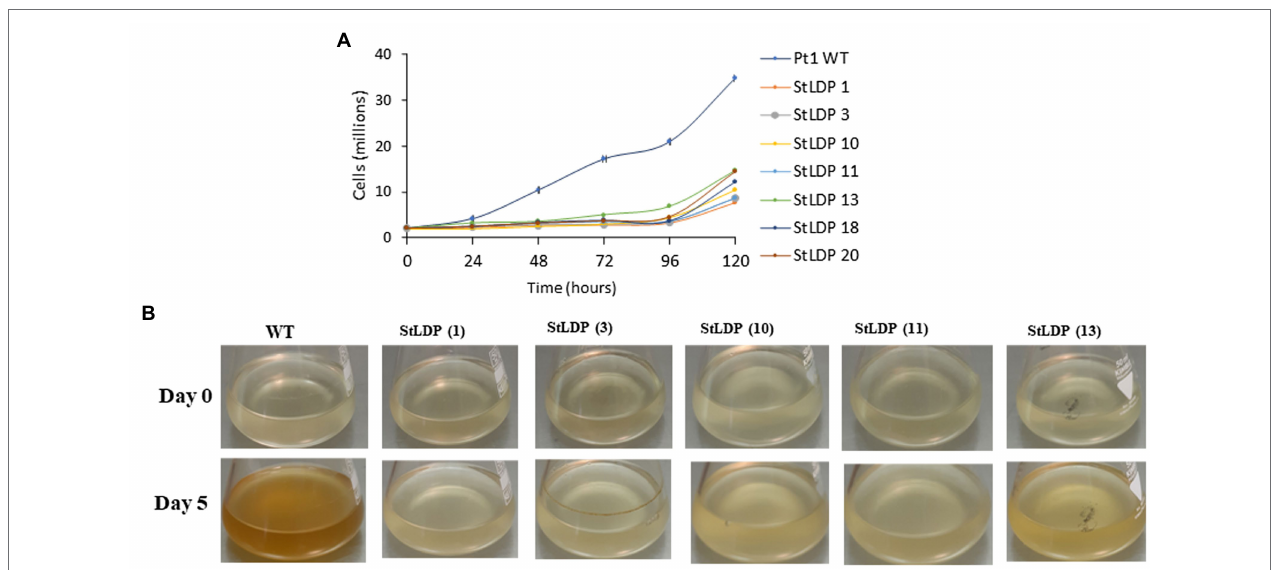
FIGURE 3 | Growth of wild-type Pt1 and StLDP -KO lines in the nutrient-replete medium. (A) Growth of the cultures monitored by cell counting. (B) Images of P. tricornutum cultures, representing relative growth from day 0 to 5 days of cultivation in the nutrient-replete medium. The initial cell density − 2 × 10 6 cells/ml. Wild-type and StLDP -KO lines were cultivated in an incubator shaker with a CO 2 -enriched atmosphere (100 ml/min) at 22 ° C with a shaking speed of 120 rpm under a light intensity of 50 μ mol photon m − 2 s − 1